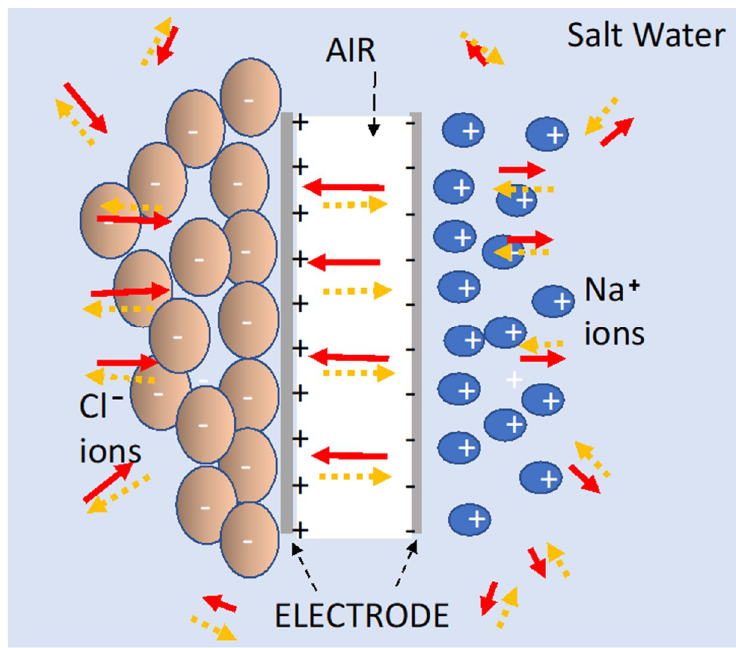
Figure 9. Top view schematic of super dielectric material (SDM) theory for a parallel plate capacitor submerged in a salt solution. In the S-DOC configuration illustrated at all points in space, both “outside” the capacitor and between the electrodes, the field due to charge on the electrodes (solid arrows) is partially cancelled by the field created by the ions (dashed arrows), or by water molecules (not shown) organized into a “liquid crystal” like